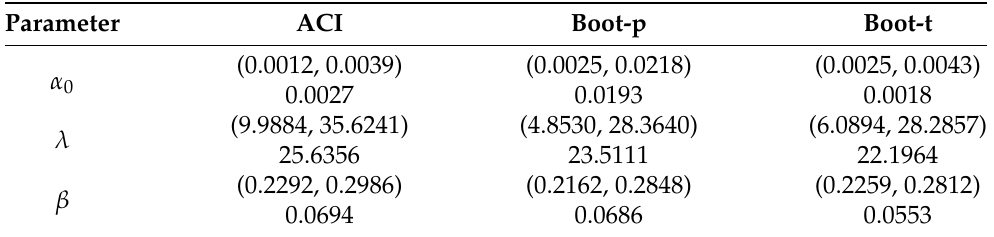
Table 12. The 95% asymptotic confidence intervals (ACI), the 95% bootstrap percentile confidence intervals (Boot-p) and the 95% bootstrap-t confidence intervals